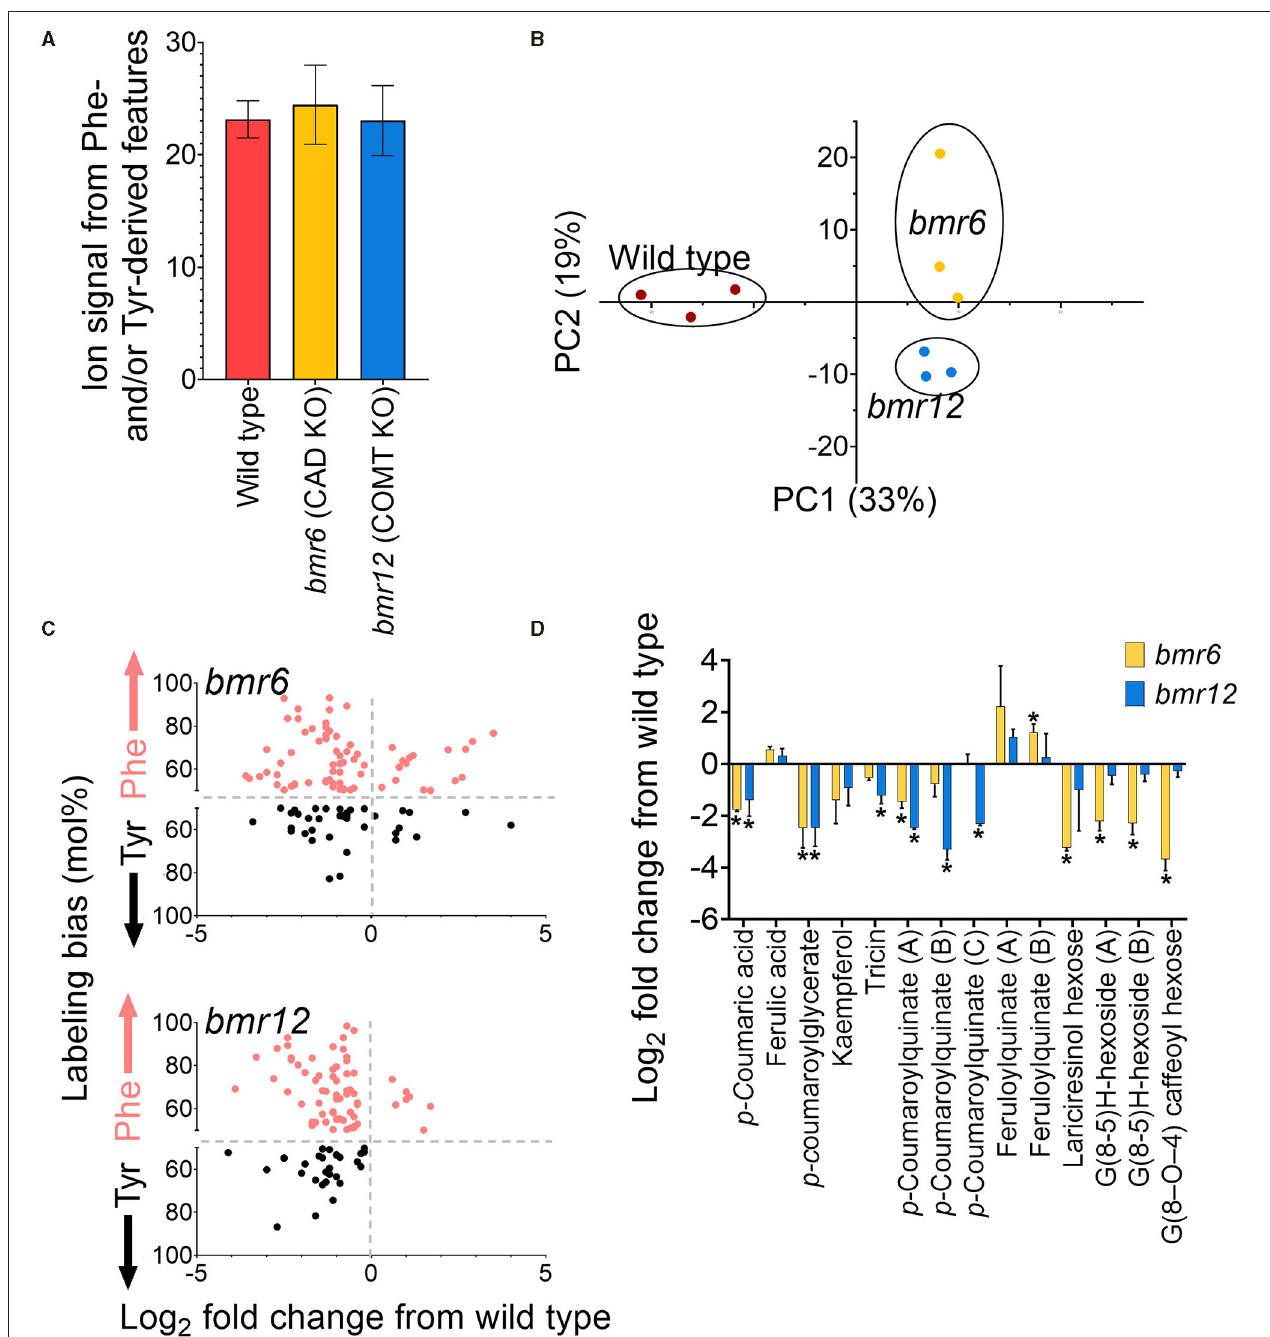
FIGURE 8 | Annotation of Phe- and Tyr-derived metabolite features in expanded leaves of two-week old bmr mutants. (A) Percentage of MS features bmr mutants and the wild-type (BTx623) samples that were retrospectively annotated as Phe- or Tyr-derived. (B) PCA analysis of Phe- and Tyr-derived features in wild-type and bmr mutants. (C) log 2 fold change in abundance for MS features is significantly altered in bmr6 and bmr12 relative to wild type ( p < 0.05). The y-axis reports the difference in the incorporation of Tyr and Phe (expressed as a mol%) for the significantly altered metabolite features. This data was extrapolated from the leaf-feeding experiments described in this manuscript. Points above the centerline represent MS features that were more labeled from Phe, and points below the centerline represent MS features that were more labeled from Tyr. (D) Log 2 fold change relative to wild type of selected metabolites in bmr6 and bmr12 that were tentatively identified by MS/MS. Stars above points denote statistical significance ( n = 3; p <